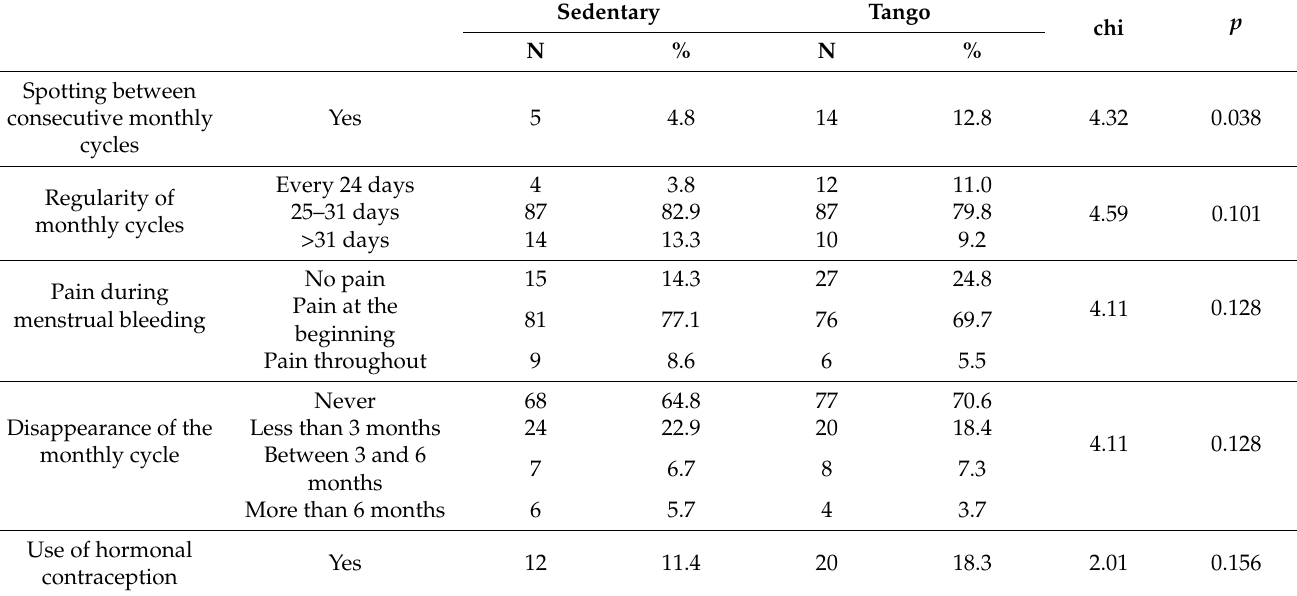
Table 4. Characteristics of the monthly cycle—nonparametric value; N—number of dancers, %—percentage of dancers, chi—test value, p —level of statistical